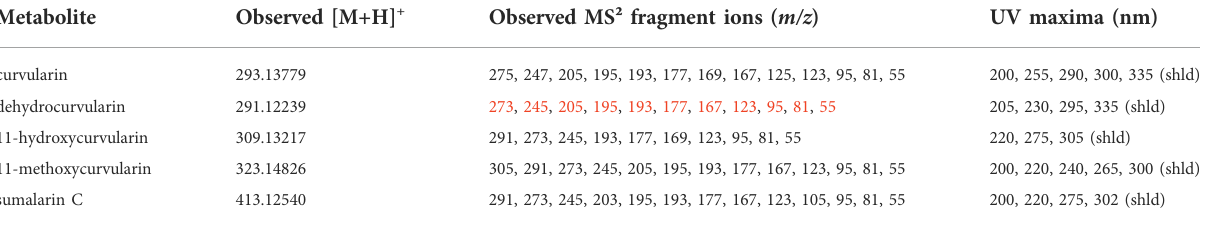
TABLE 1 Relevant observed [M+H] + , associated MS 2 fragment ions m/z and UV maxima from dehydrocurvularin-associated metabolites annotated in this study by